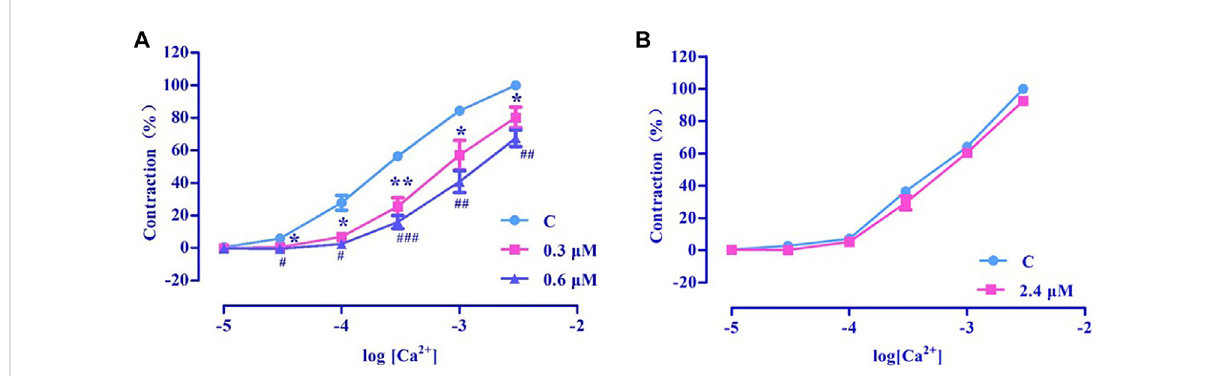
FIGURE 12 Effects of extracellular Ca 2+ in fl ux on nuciferine induced vasorelaxation. The data are expressed as the means ± SD of 6 – 8 rats ( n = 6 – 8). (* p < 0.05 and ** p < 0.01 vs. control group; # p < 0.05, ## p < 0.01 and ### p < 0.001 vs. control group).